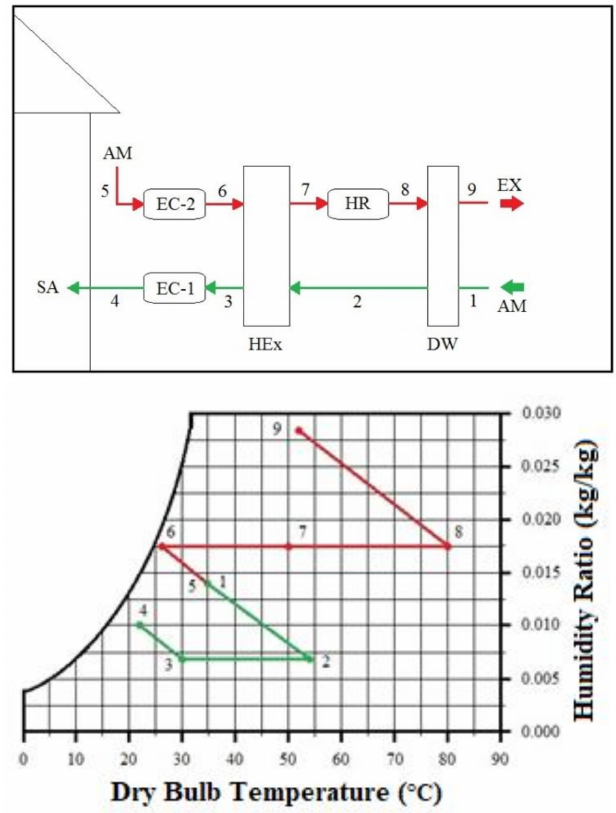
Figure 3. Modified Ventilation